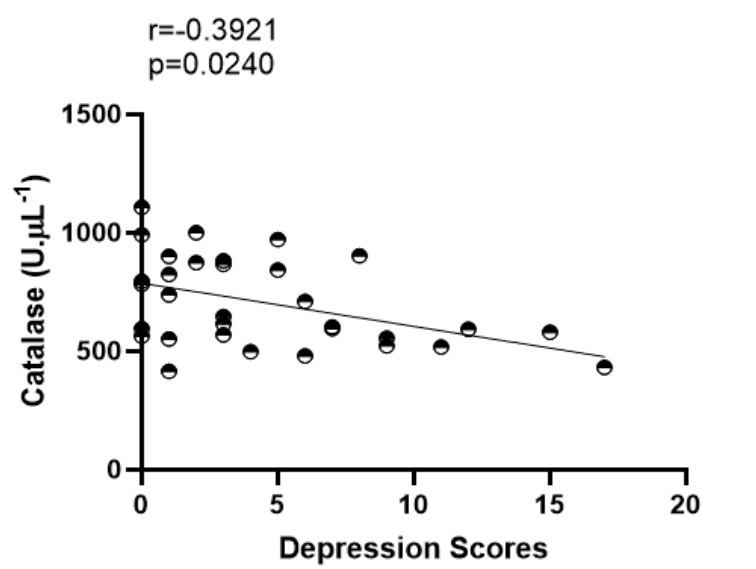
Figure 1. Correlation analysis among catalase and intensity of depression symptoms in master ath- letes.